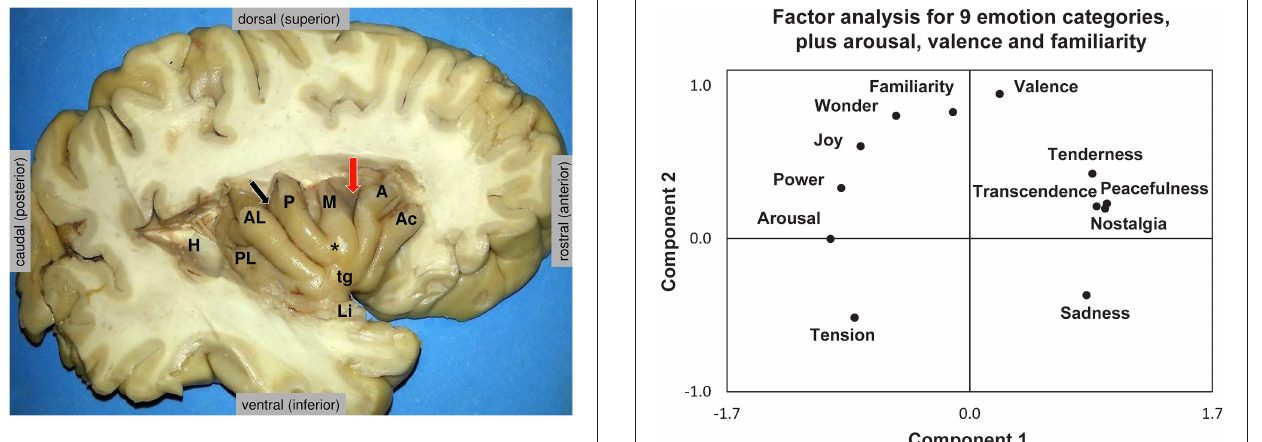
FIGURE 2 | Anatomy of the insula, as disclosed in the depth of the lateral fissure. H = the posterior medial stub of the transverse temporal gyrus of Heschl (primary auditory cortex) that was resected to uncover the posterior long insular gyrus. The central sulcus (black arrow) divides the lateral surface of the insula into a small posterior insular lobule, composed of the anterior long (AL) and posterior long (PL) insular gyri that converge to the limen insulae (Li), and a large anterior insular lobule, composed of the anterior short (A), the middle short (M) and the posterior short (P) insular gyri that converge to the apex of the insula ( * ). The anterior face of the insula displays a variably present accessory insular gyrus (Ac) and a constant transverse insular gyrus (tg) that connects with the orbital surface of the frontal lobe. The red arrow marks the sulcus between the anterior short and middle short gyri, where the functional “overlap region” was found by Kurth et al. (2010). Figure courtesy of Drs. Thomas P. Naidich and Mary E. Fowkes, the Icahn School of Medicine at Mt. Sinai, New York.